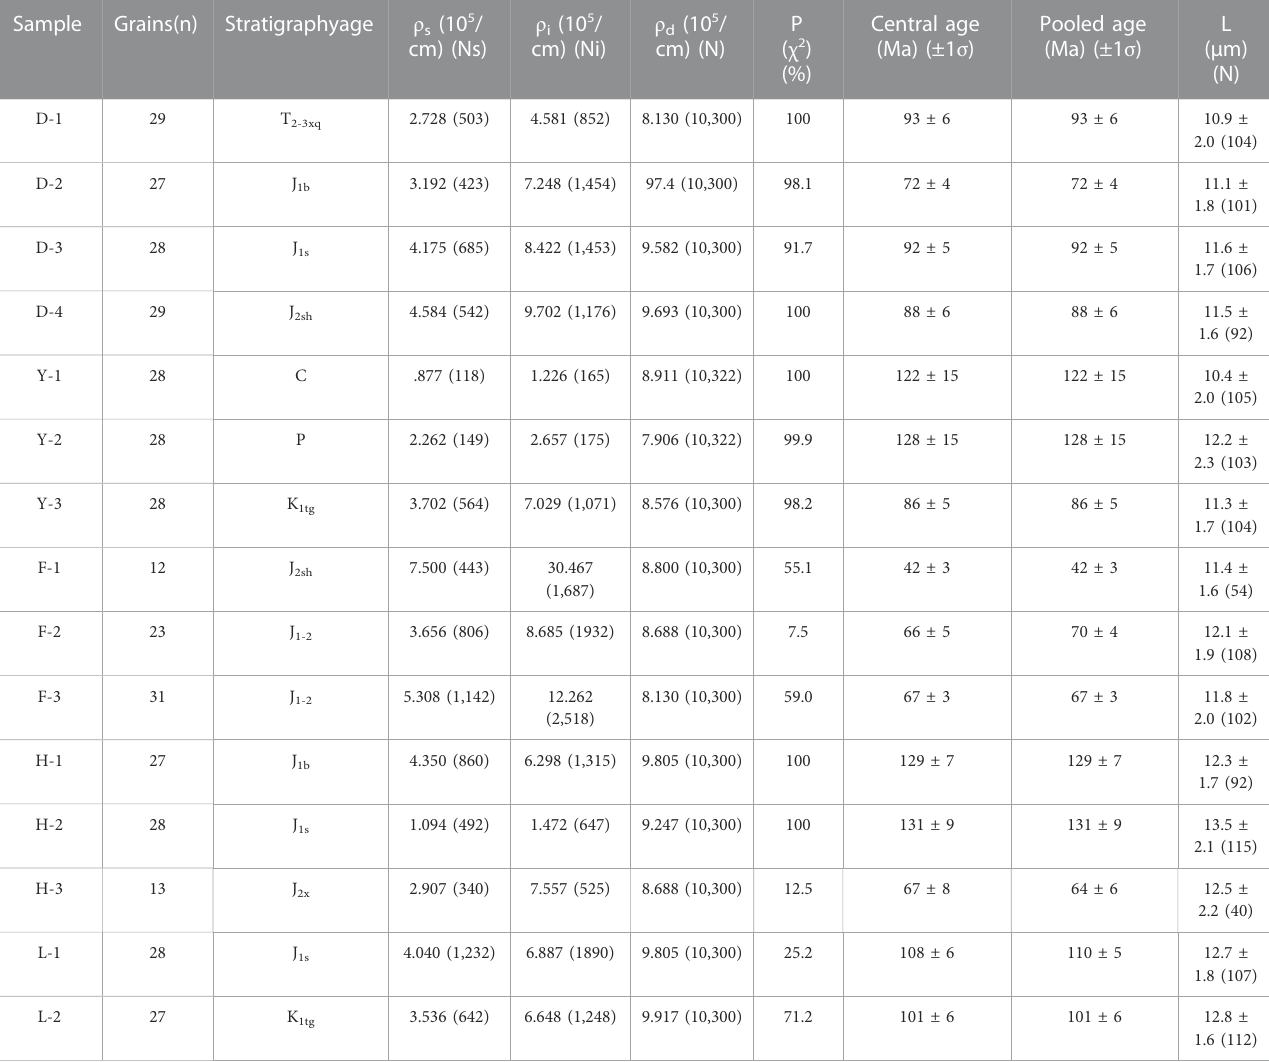
TABLE 2 Apatite fi ssion track data of the northern Junggar Basin.